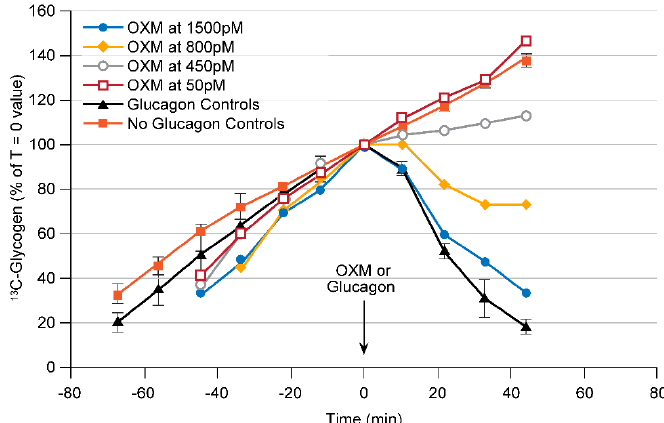
Figure 3. The development of a perfused liver assay for the assessment of glucagon receptor (GcgR) activation for application to GLP1R/GcgR dual agonists. 13 C NMR spectra used in this assay were similar to those in Figure 2A. The dose titration of native oxyntomodulin is shown, with an approximate EC 50 for induction of glycogenolysis of 700 pM in livers from mice expressing the humanized glucagon receptor. Adapted from reference [19] .